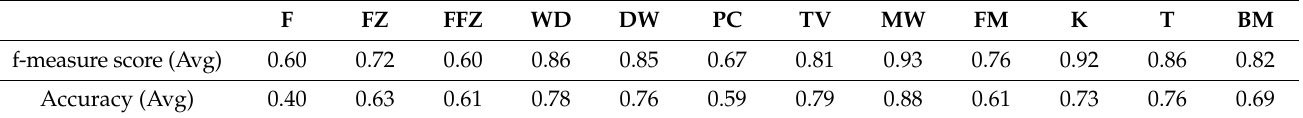
Table 5. Results of SC-EV algorithm applied on REFIT data with k =